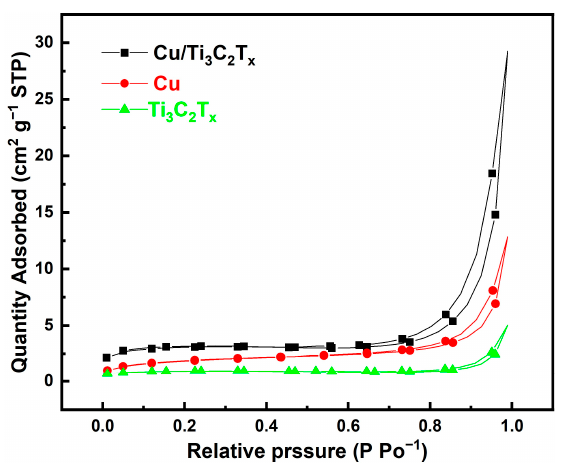
Figure 4. N 2 adsorption/desorption isotherms for Ti 3 C 2 T x , Cu and Cu/Ti 3 C 2 T x .